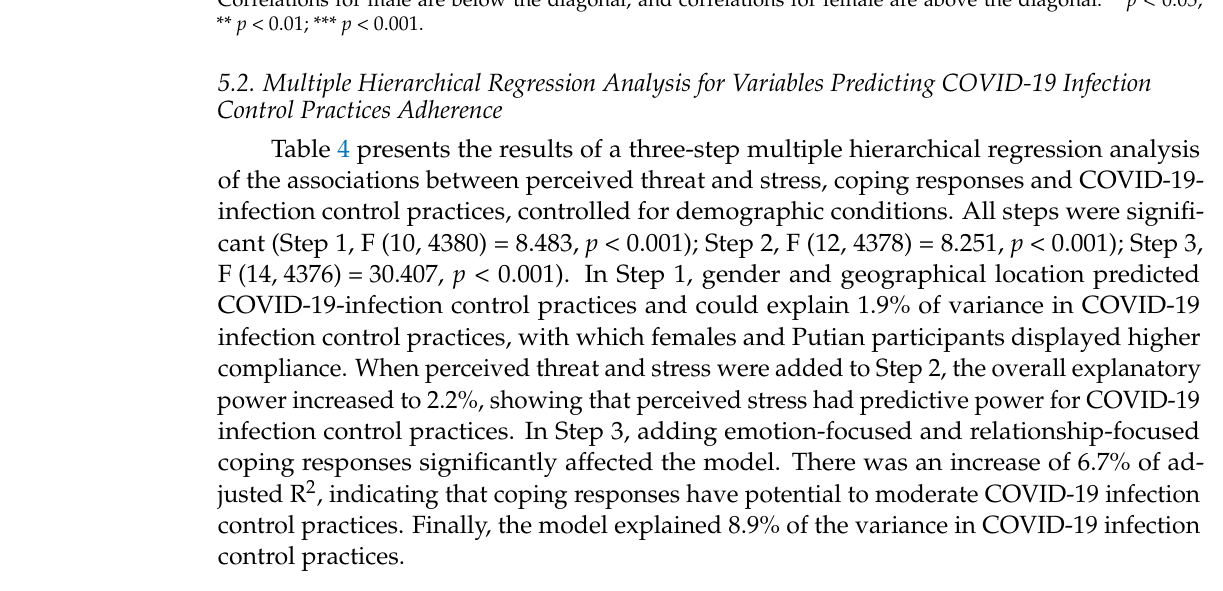
Predictors of COVID-19 infection control practices adherence using multiple hierarchical